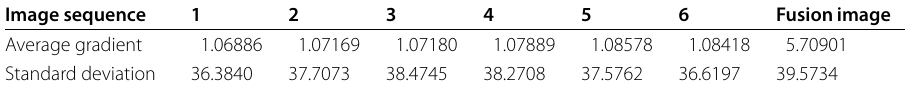
Table 2 Data comparison between different depth images and fusion images Image